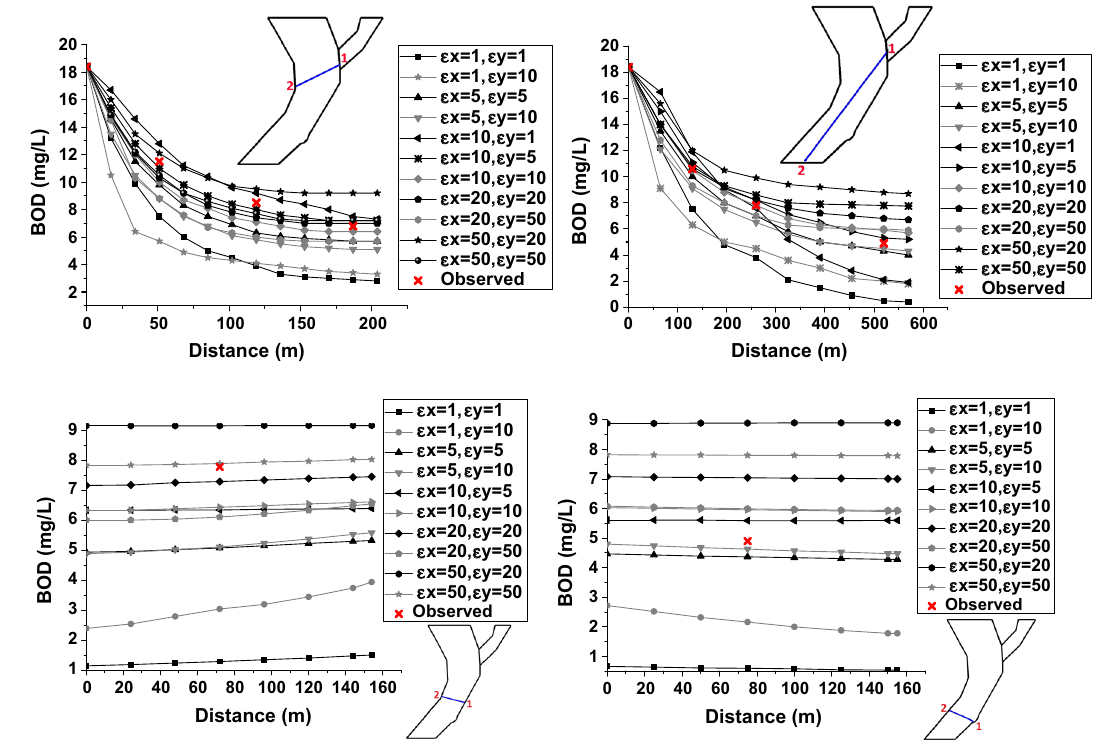
Fig. 4 Calibration results of BOD concentrations along Diyala River confluence with Tigris (June